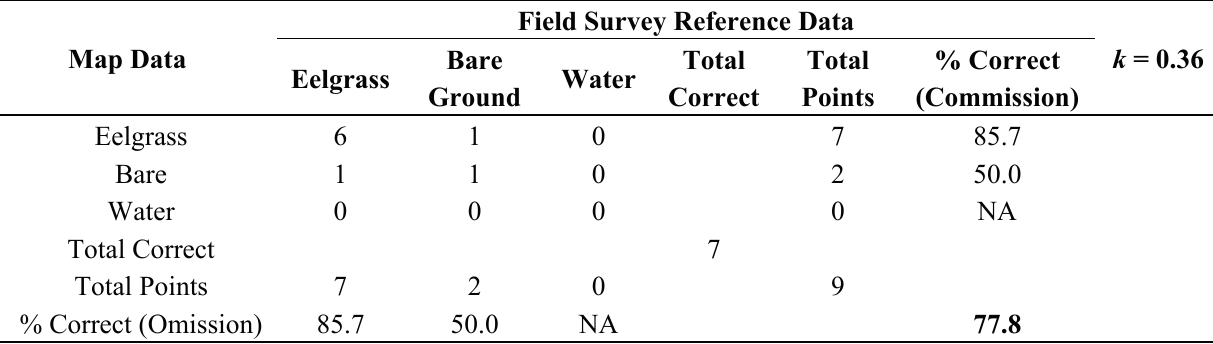
Table A5. Initial classification of habitats in Hotsprings